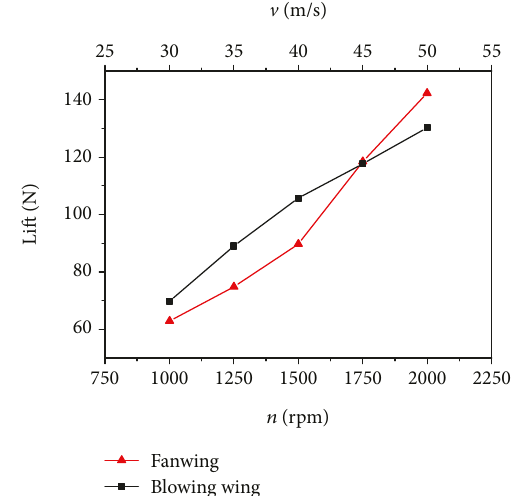
Figure 13: Lift curve changes with the rotating speed and blowing velocity.